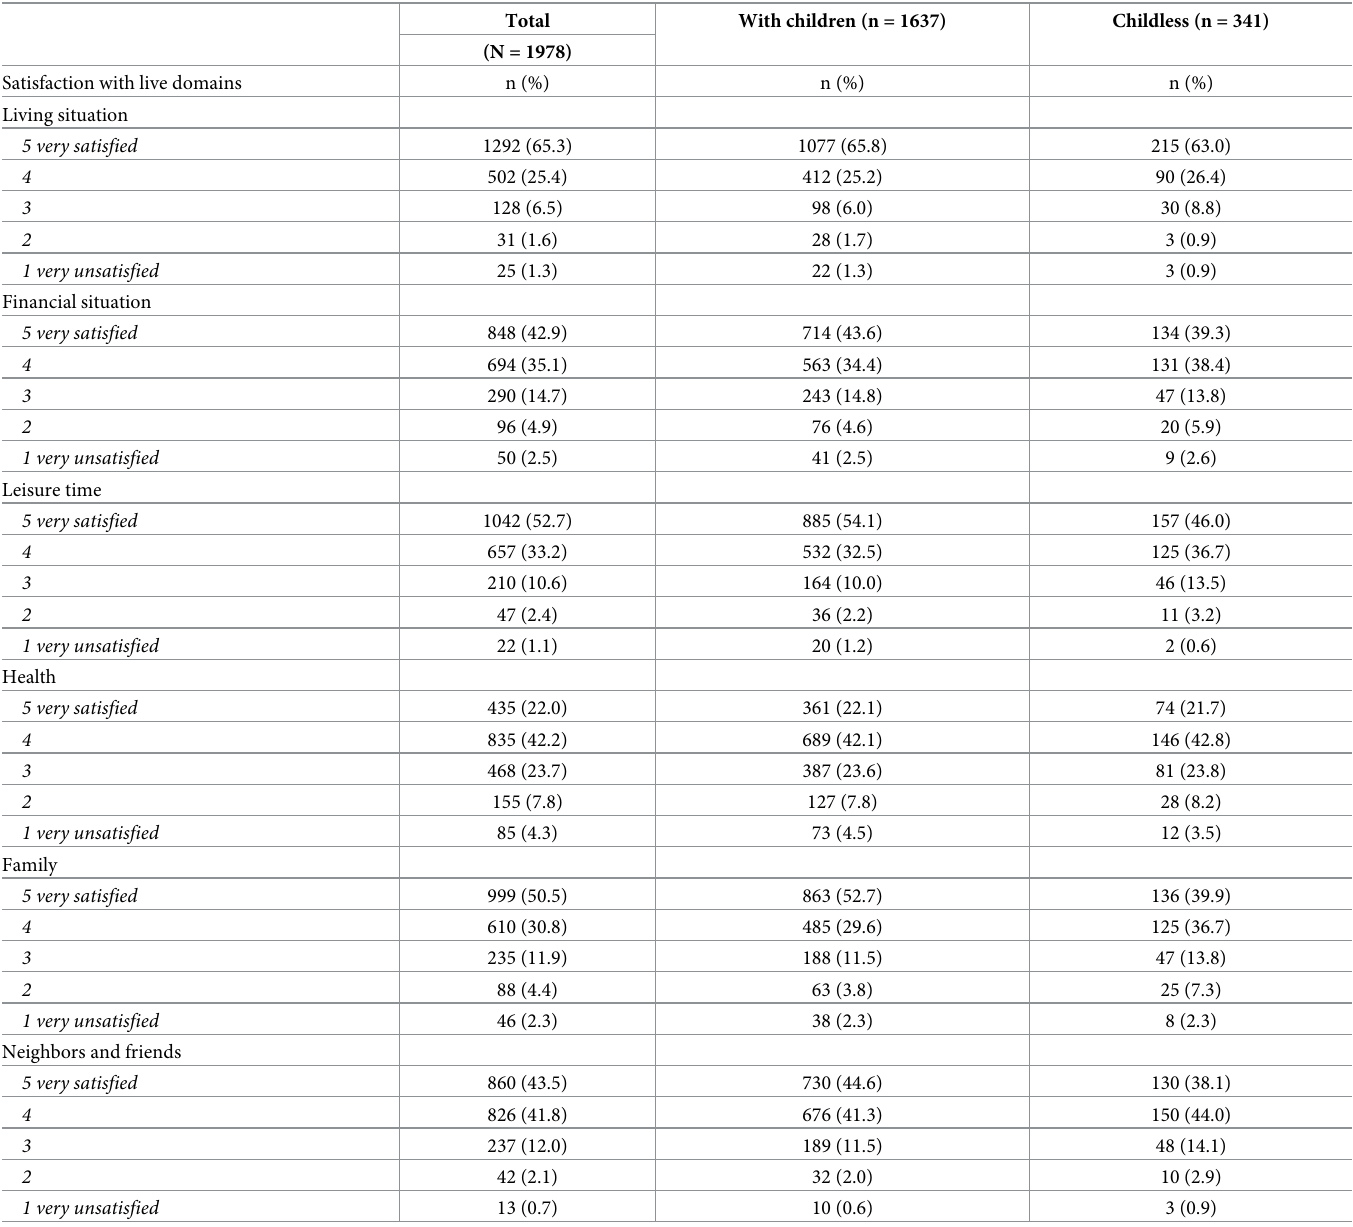
Table 2. Description of the life